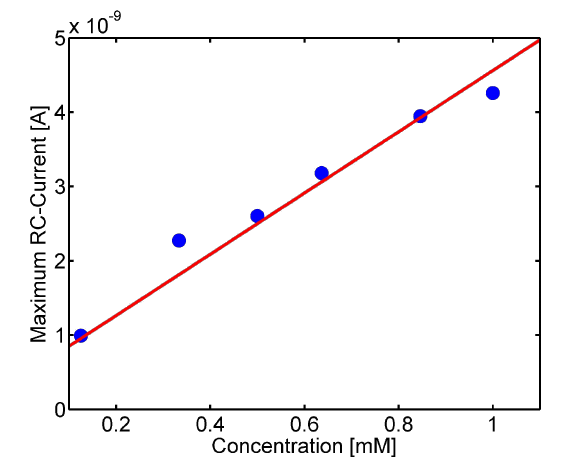
Figure 3: Concentration dependency of an intersection in sequential data acquisition. Data was recorded during cyclic voltammograms at different concentrations of potassium hexacyanoferrate in 100 mM KCl and represents the absolute difference between the cathodic peak current and a measurement using only the background electrolyte.